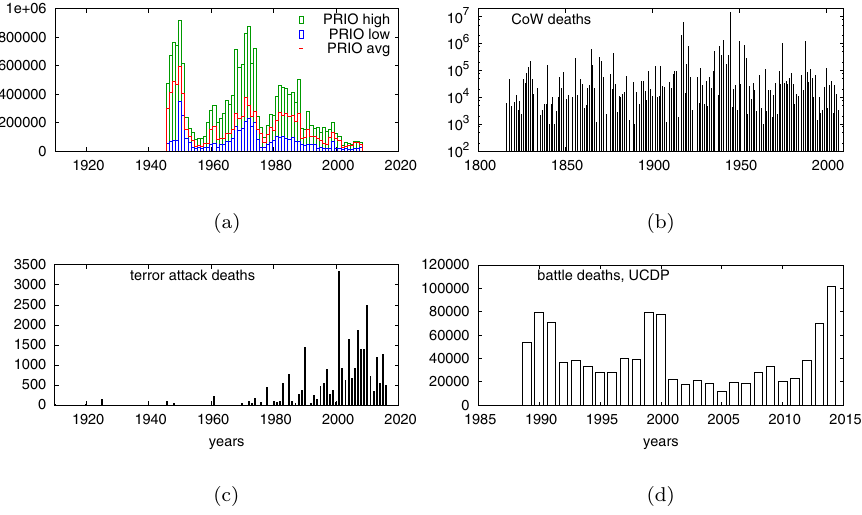
Fig. 1. Statistics of fatalities over years for wars and con°icts: (a) Number of people died in con°icts during 1946 – 2008, according to the PRIO database, 43 with low, high and average estimates; (b) Number of human death according to the CoW database 37 during 1816 – 2007, consisting of Intra state, Inter state, Extra state and Non-state wars; (c) Number of human death in terror attack 46 during 1910 till July 2016; (d) Number of human deaths in battles according to UCDP database 45 during 1989 –